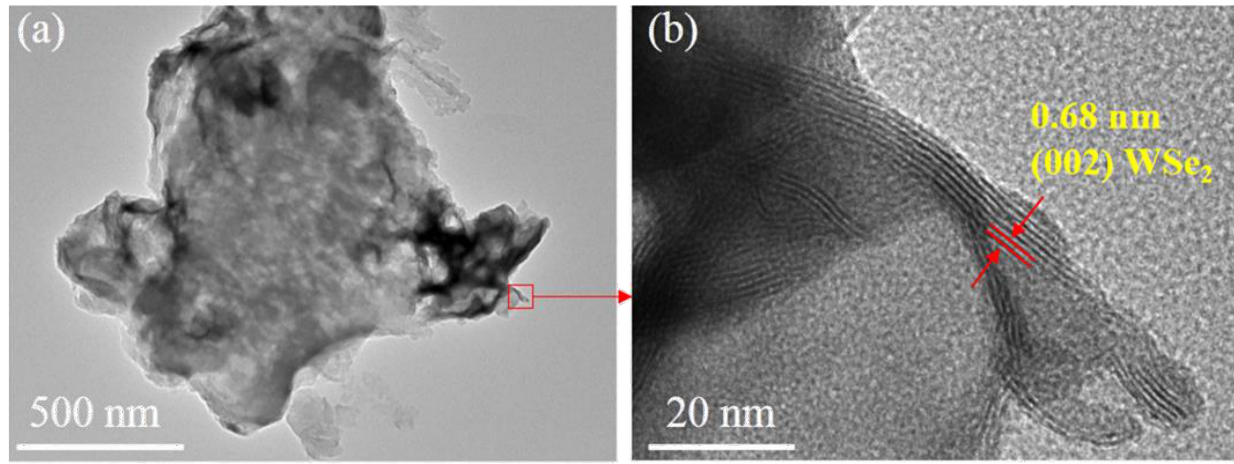
Figure 3. ( a ) TEM image of CNW2 and ( b ) HRTEM image of CNW2. The XPS survey spectra of WSe 2 , CNW2, and PCN are shown in Figure 4a. The characteristic peaks of the four elements, C, N, W, and Se, can be observed from the